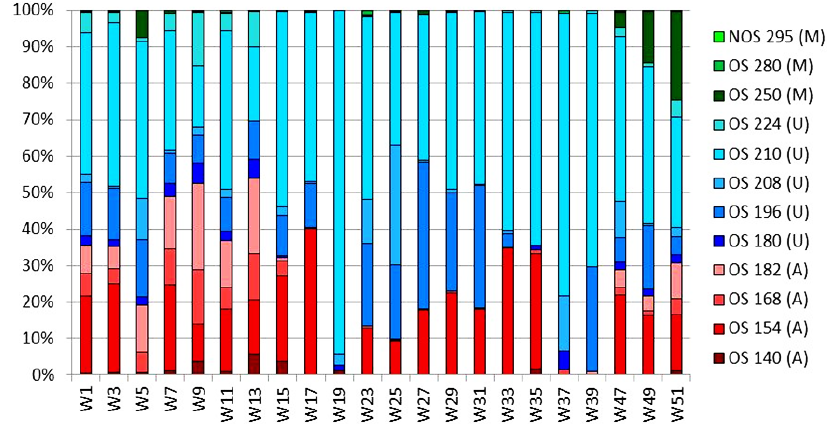
Figure 7. Relative composition of organosulfates from monoterpene (M), anthropogenic (A), and unknown (U) precursors observed at Zeppelin Mountain, Svalbard, 2008. Approximately two samples are collected for each month, W1 and W3 from January; W5, W7 and W9 from February; W11 and W13 from March; W15 and W17 from April; W19 from May, W23 and W25 from June; W27 and W29 from July; W31, W33 and W35 from August; W37 and W39 from September; W47 from November; and W49 and W51 from